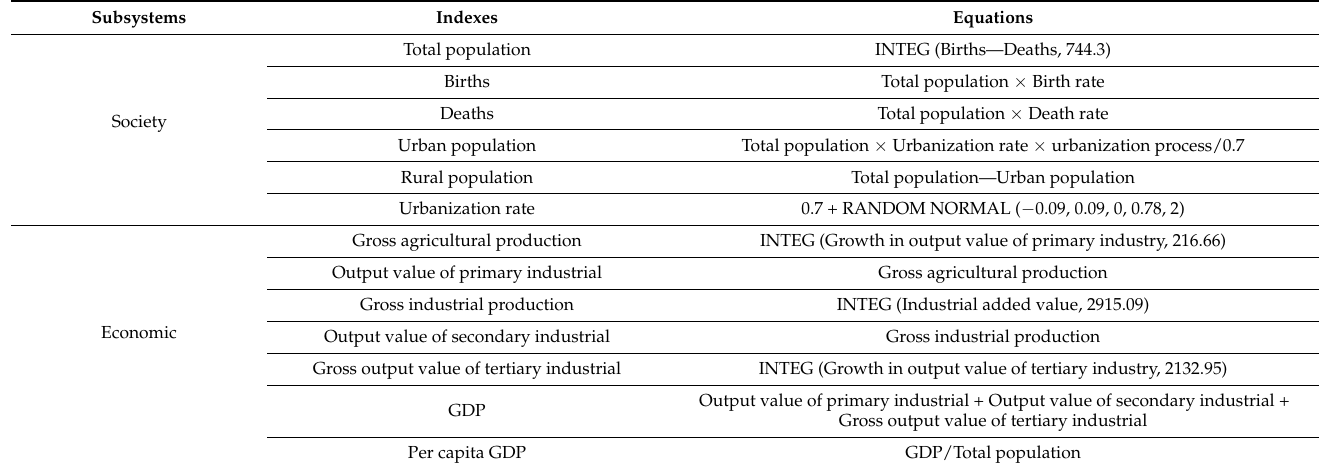
Table 1. Core indexes and equations of the